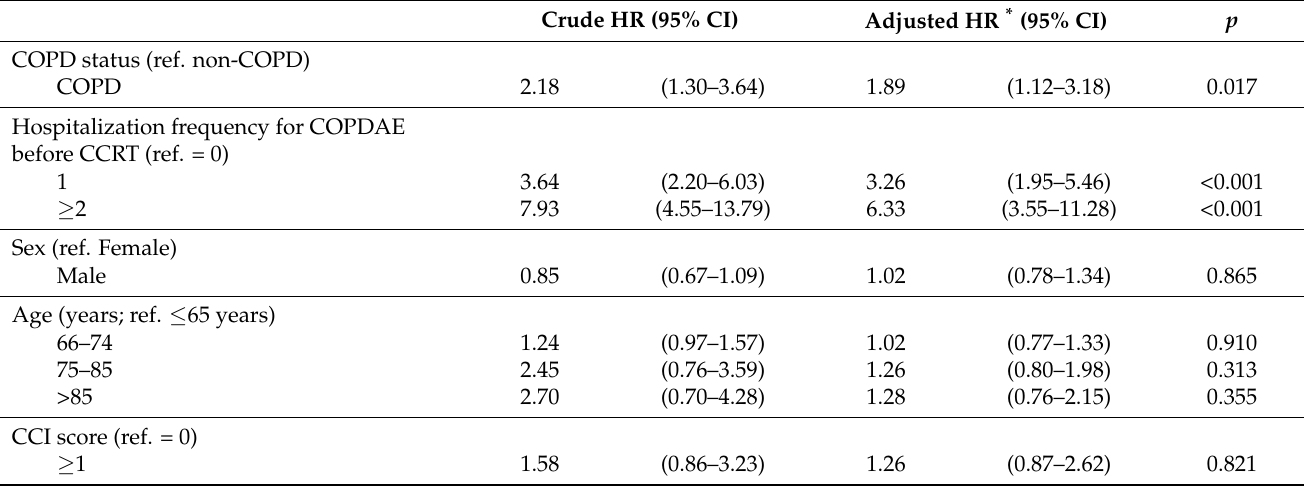
Table 2. Cox proportional hazards analysis of all-cause mortality for patients with muscle-invasive urothelial carcinoma of the bladder with and without current-smoking-related COPD before definitive